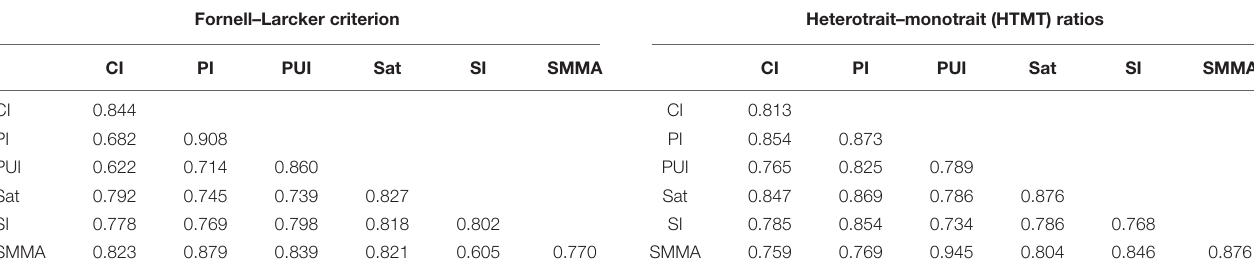
TABLE 3 | Discriminant